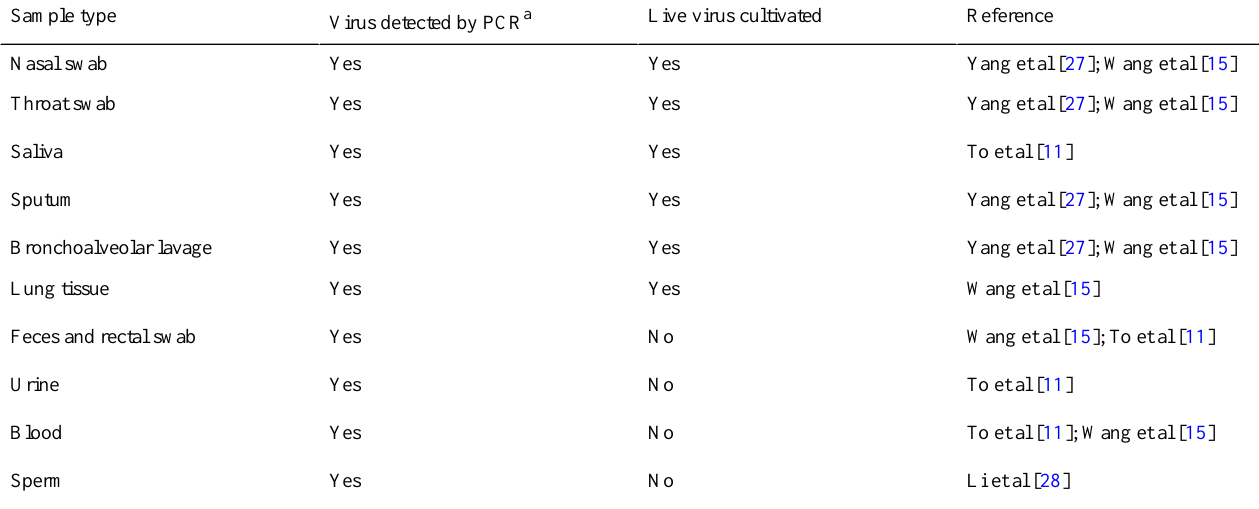
Table 1. Viral detection and cultivation of live virus in clinical samples to